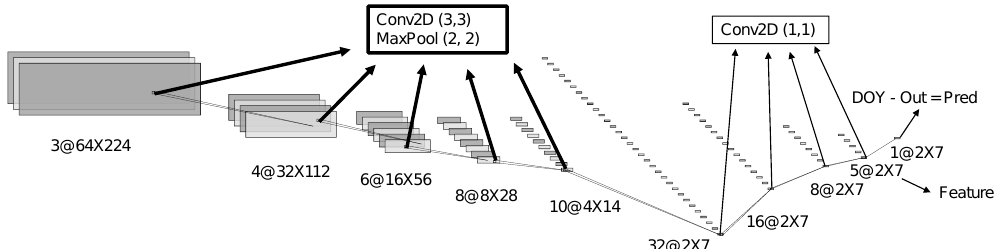
Figure 5. Schematic representation of the single date convolutional neural network architecture. The numbers represent the dimensions of the tensors and the names in the boxes are the operations applied. DOY stands for the day of the